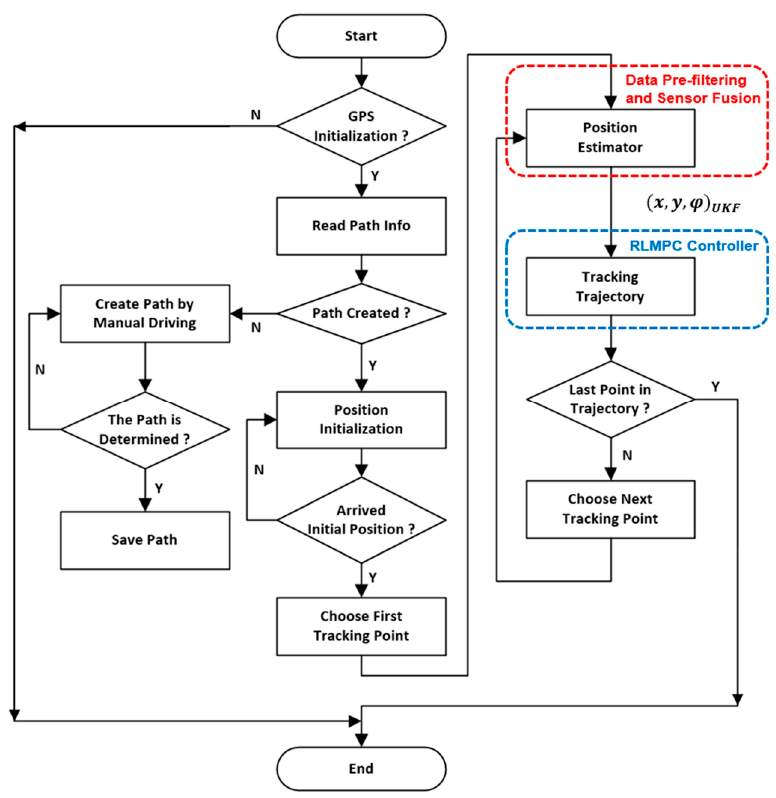
Figure 1. Overall operation flowchart.